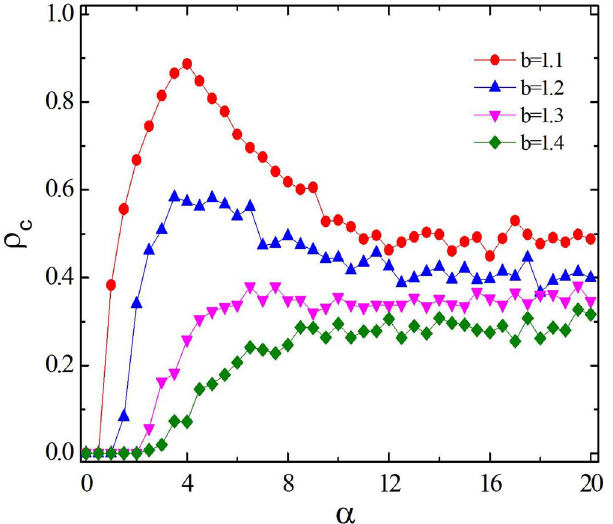
Figure 2. The fraction of cooperation ρ c as a function of the preference selection parameter α . The parameter u is fixed at 0.5. Other parameters are consistent with those in Fig. 1. It is observed that for each determined b - value, when α > 12.0, the concentration of cooperation will be maintained at their respective